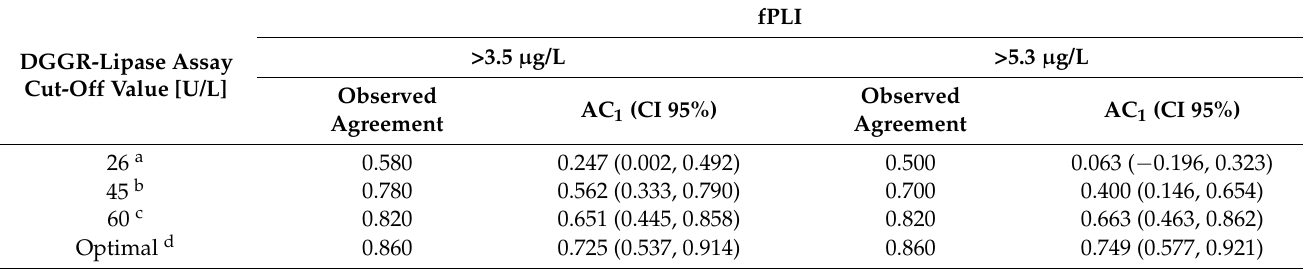
Table 1. Chance-corrected agreement (expressed as Gwet’s AC 1 coefficient with the 95% confidence interval [CI 95%]) between feline pancreatic lipase immunoreactivity (fPLI) assay and DGGR-lipase assay at various cut-off values of the DGGR-lipase assay.